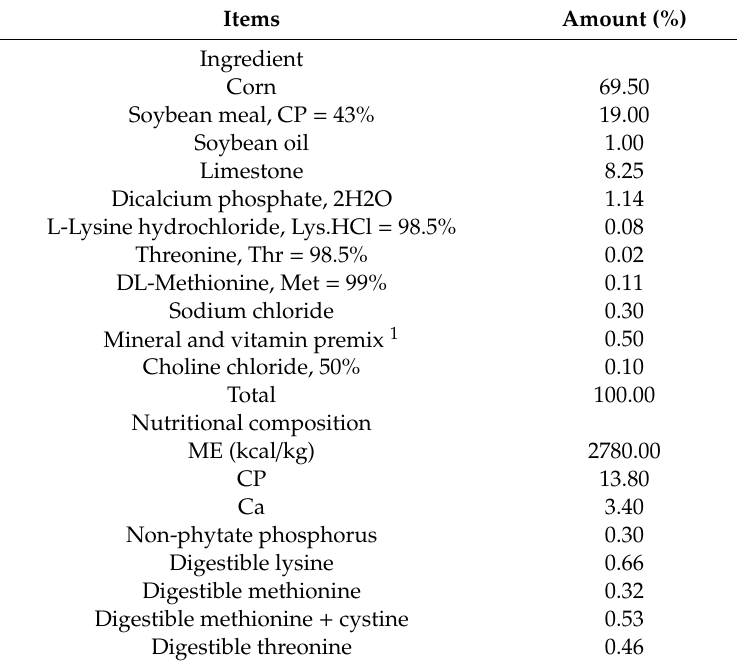
Table 1. The composition and nutrient levels of the basal diet (%, as